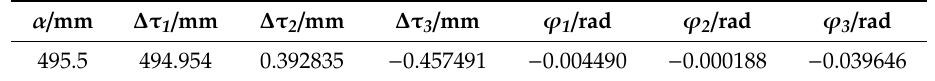
Table 3. Actual boundary conditions prescribed on shell curve edges with respect to Cartesian coordinate O τ 1 τ 2 τ 3 .